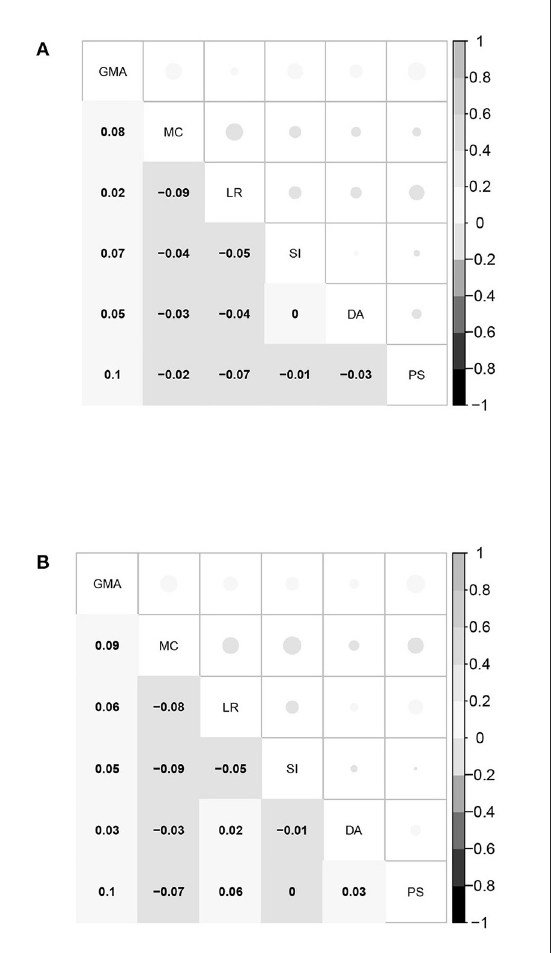
FIGURE5 Correlation coefficients between the six abilities (the general ability and the five domain-specific abilities) of the FIBF model for students in the fourth and eighth grades. GMA, general mathematical ability; MC, mathematical computation; LR, logical reasoning; SI, space imagination; DA, data analysis; PS, problem solving. (A) Fourth grade. (B) Eighth